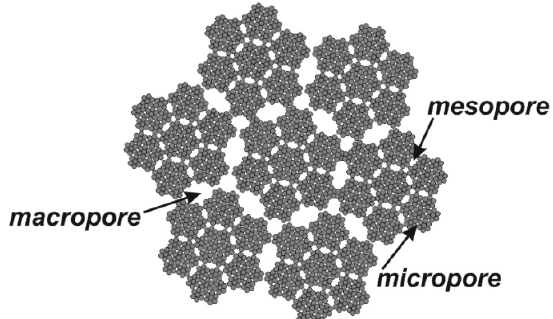
Figure 1. A simplified model of self-assembly products (Julienne fractal)